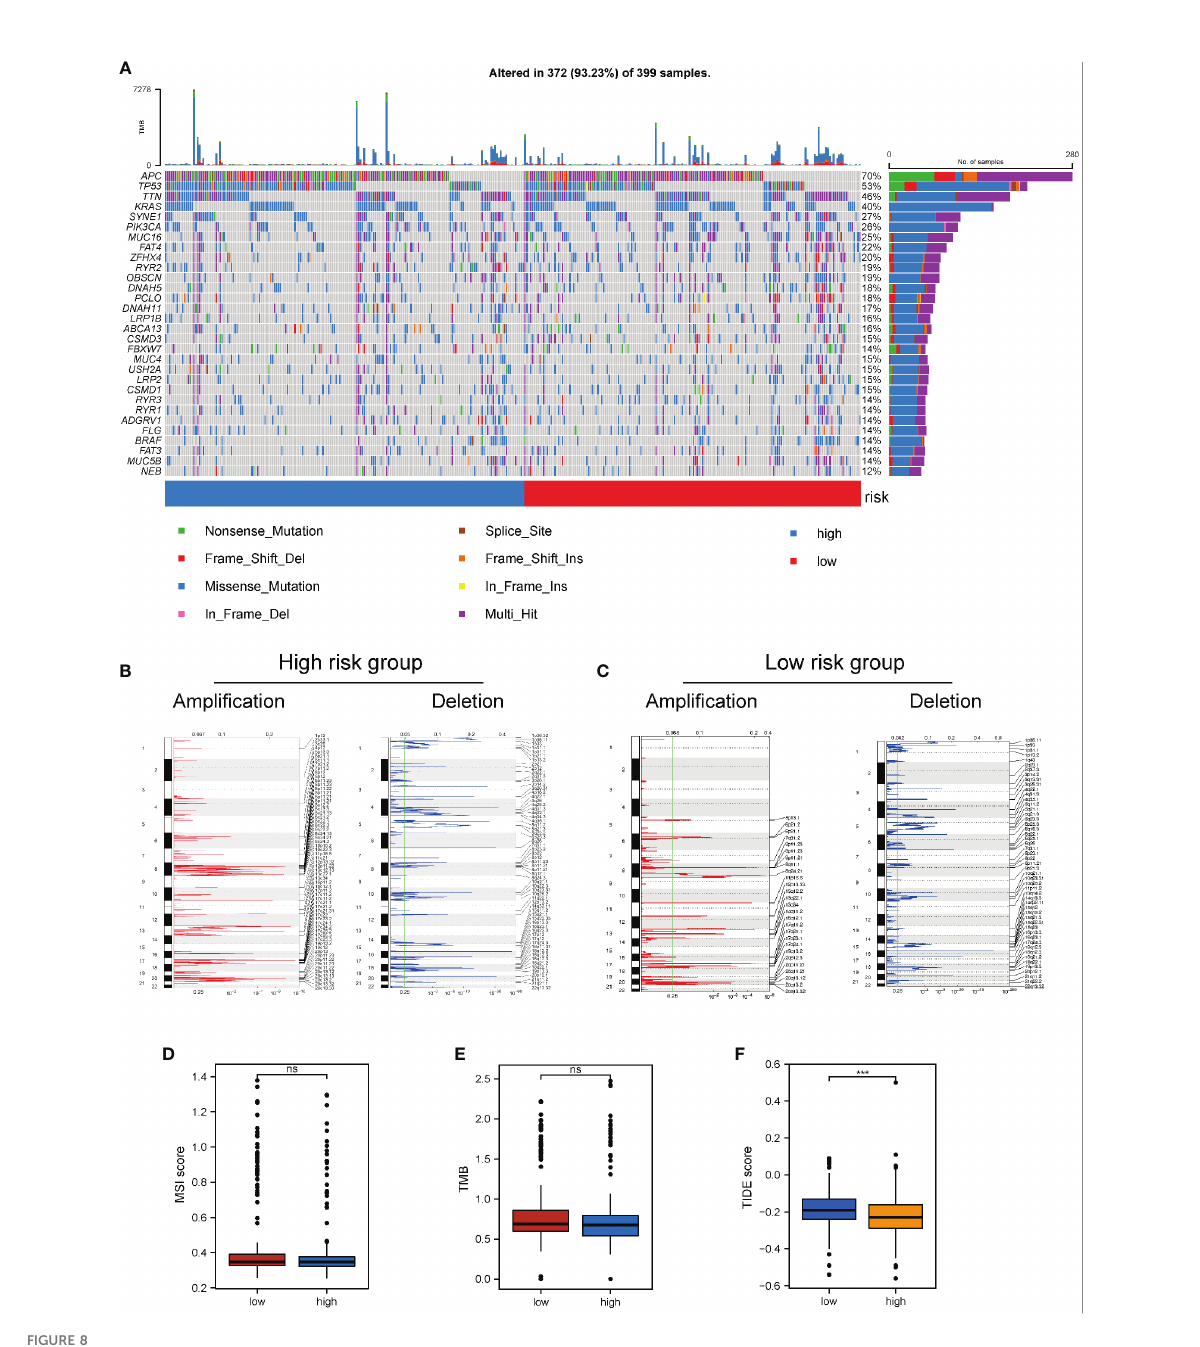
FIGURE 8 Impact of necroptosis-related risk grouping on genetic variation and immunotherapy in COAD samples. (A) Mutation map of common tumorigenic driver genes in patients in the high- and low-risk groups. Mutation information per gene per sample is presented as a waterfall plot, and different colors represent different types of mutation. The subsection above the legend shows the sudden change load; (B, C) Changes in the copy number levels of different genes in the high-risk and low-risk groups, where genes with signi fi cant copy number increase in red and genes with signi fi cant copy number deletions in blue; (D, E) Comparison of the difference in MSI level and TMB level between patients in the high- and low-risk groups, respectively; (F) Discrepancy between the high-risk and low-risk groups based on the tide score calculated from the tide database. *** P < 0.001. "ns" represents "no signi fi